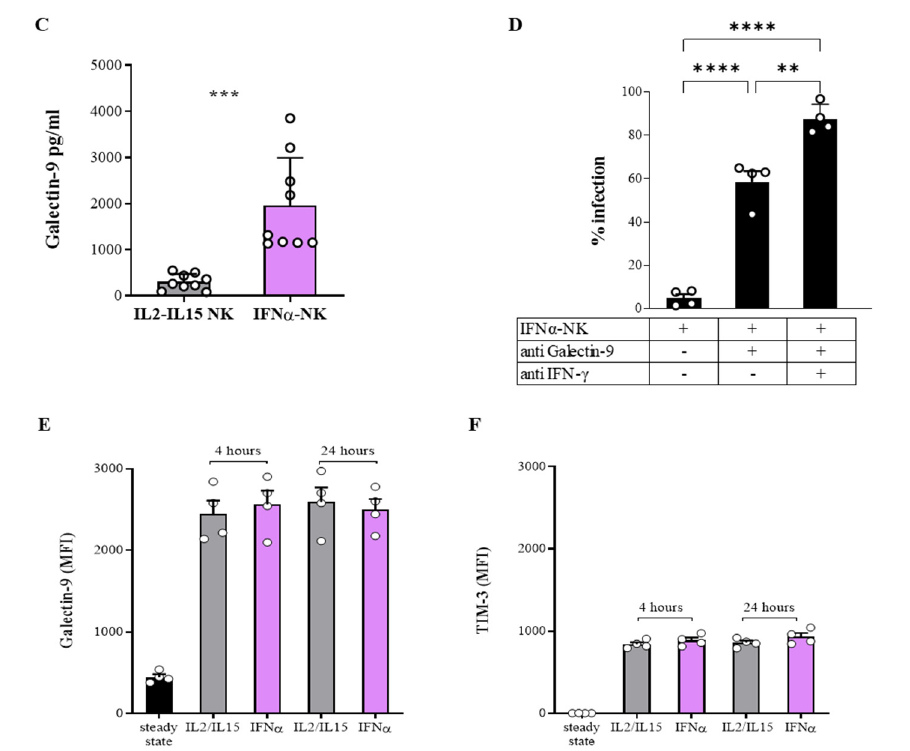
Figure 5. Secretion of galectin-9 and IFN- γ mediated HCV suppression by IFN α -NKs. ( A ) The volcano plot displays extracellular proteins ( n = 190) differentially expressed in the secretome of IFN α -NKs as compared with the secretome of untreated NK cells, as identified and quantified with MS-based quantitative proteomics. Plotted along the x -axis is the mean of log2 fold-change; along the y -axis is the negative logarithm to the base 10 of p -values from Student’s t-test. The vertical black dashed line and the horizontal line reflect the filtering criteria (fold change ≥ 2.0 and p -values ≤ 0.05). Significant hits are depicted in red. The annotated dots are the four data points that have the largest distance from the origin and are above the fold change ≥ 3.0 (vertical red dashed line) and p -values ≤ 0.05 thresholds. ( B ) Correlation between secretome data of IFN α -NKs ( x -axis) and IL2/IL15-NKs ( y -axis). Relative expression levels as determined with MS-based quantitative proteomics are plotted for 190 proteins. Linear regression is indicated. Red dashed lines reflect fold change ≥ 3.0. The annotated red dots represent four proteins that were over-3-fold upregulated in the IFN α -NK secretome. ( C ) Levels of galectin-9 (pg/mL) in the conditioned media of NK cells from different donors ( n = 11) activated with IL2/IL15-NKs (gray bars) or IFN α -NKs (lilac bars), as determined with the ELISA. Mean values ± SEM are shown. ( D ) Infection rates (percentage of control) of HCV-Huh7.5 cells exposed in transwells to IFN α -NKs. Infection rates were calculated by measuring HCV-Ag levels released in the culture media seven days after co-culture. Where indicated, anti-galectin-9 neutralizing antibody (10 µ g/mL) and anti-IFN- γ neutralizing antibody (10 µ g/mL) were added. Each dot represents the average of three technical replicates from one donor ( n = 4). Mean values ± SEM are shown. ( E , F ) Mean fluorescence intensity (MFI) of intracellular galectin-9 and TIM-3 ( F ) signals in CD3 - CD56 + NK cells as calculated with flow cytometry in the steady state and 4 or 24 h after stimulation with either IL-2/IL-15 or IFN- α . Each dot represents a technical replicate. Mean values ± SD are shown. Statistical analyses were performed using unpaired Student’s t -test ( C , E , F ) and the one-way ANOVA with Tukey’s multiple comparisons test ( D ). ** p < 0.01, *** p < 0.001, **** p <